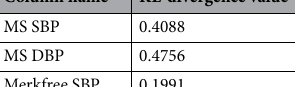
Figure 7. ( a ) Histogram plot of three devices for SBP, ( b ) Histogram plot of three devices for DBP, ( c ) A plot showing normalized ideal expected gaussian distribution plotted over frequency distribution obtained clinical study for the particular case of MS SBP. These two series are used to obtain the KL divergence for MS SBP. Similar series is obtained for all other measurements and to ultimately obtain the values in Table 1. Column